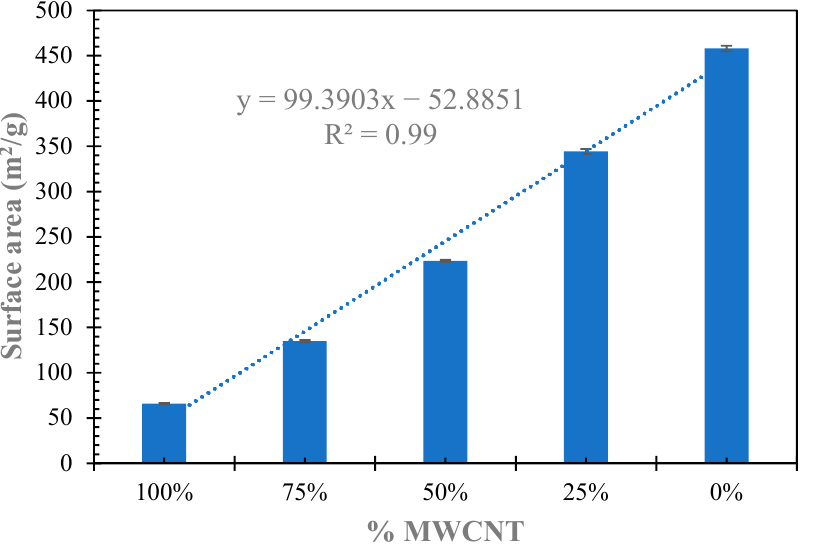
Figure 3. Specific surface area data for all composite and end-member samples. Trendline and equa- tion showing the relationship between the % MWCNT in the composite material and its measured BET specific surface area. Error bars represent the standard deviation of triplicate samples.